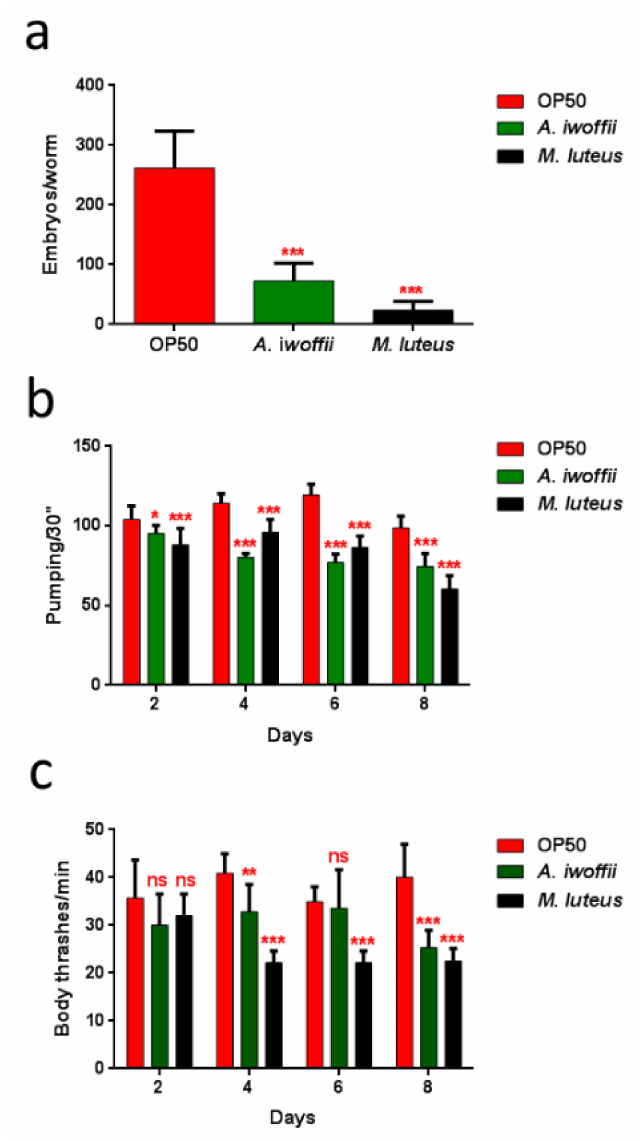
Figure 9. ( a ) Average embryos production per worm of M. luteus -, A. iwo ffi i - and OP50-fed animals. Bars represent the standard deviations. ( b ) Pharyngeal pumping rate after continued exposure to the indicated bacteria and worms fed with OP50 were used as controls. The contractions were measured for 30 s and determined from the mean of 10 worms for each bacterial strain. ( c ) Body bend frequency of worms fed with OP50, M. luteus and A. iwo ffi i from one-day-adult stage. The number of thrashes was measured in a time period of 60 s. Statistical analysis was performed by a one-way ANOVA with the Bonferroni post-test; asterisks indicate significant di ff erences (ns as non-significant; * p < 0.05, ** p < 0.01, *** p <